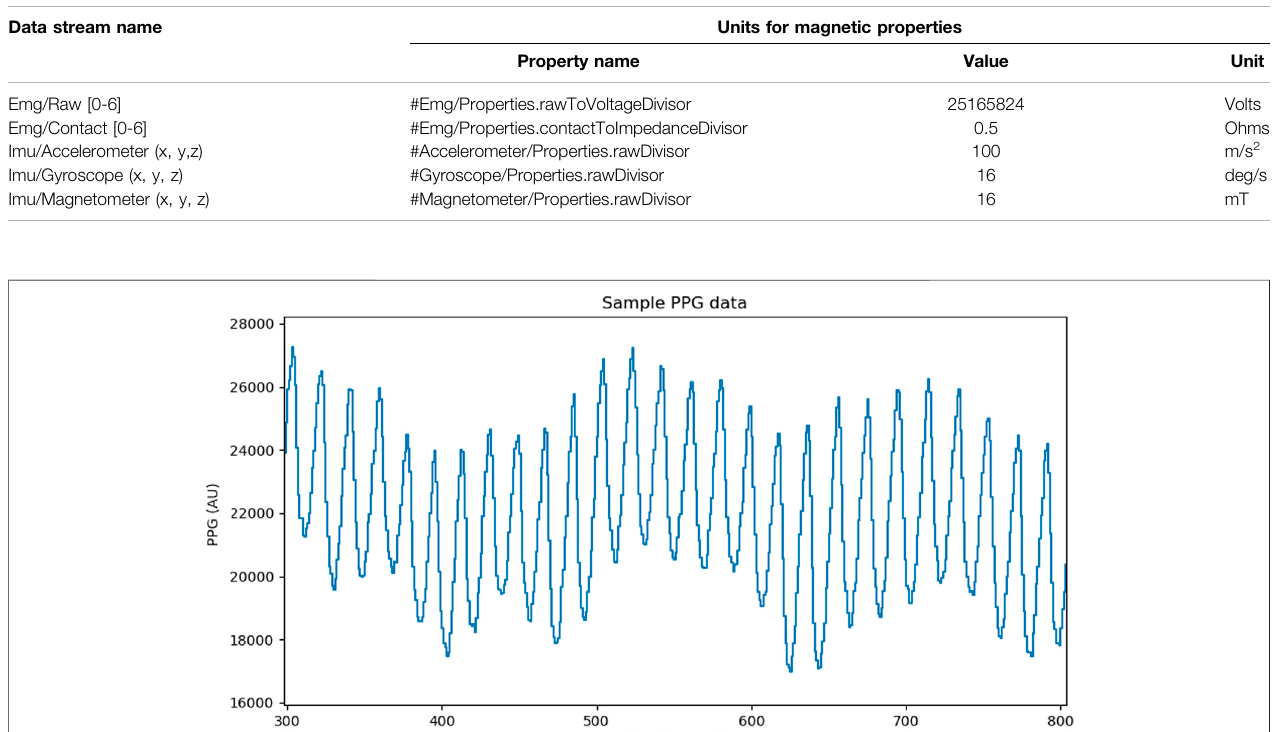
TABLE 2 | Units, names and scalar values for normalised properties.